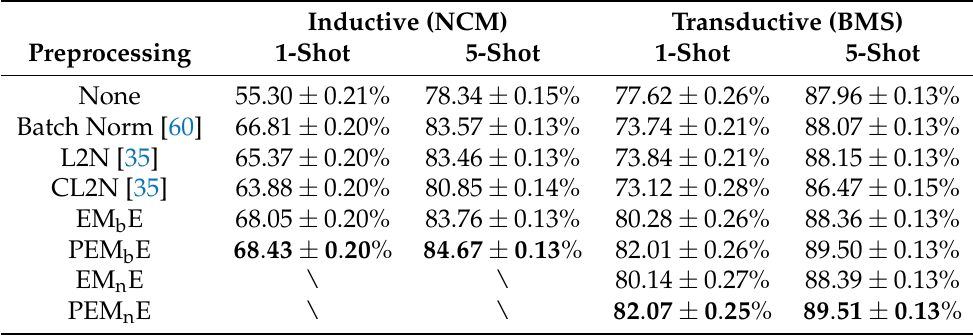
Table 6. Comparison of 1-shot and 5-shot accuracy on miniImageNet (backbone: WRN) when using various preprocessing steps on the extracted features. Best results are in bold.